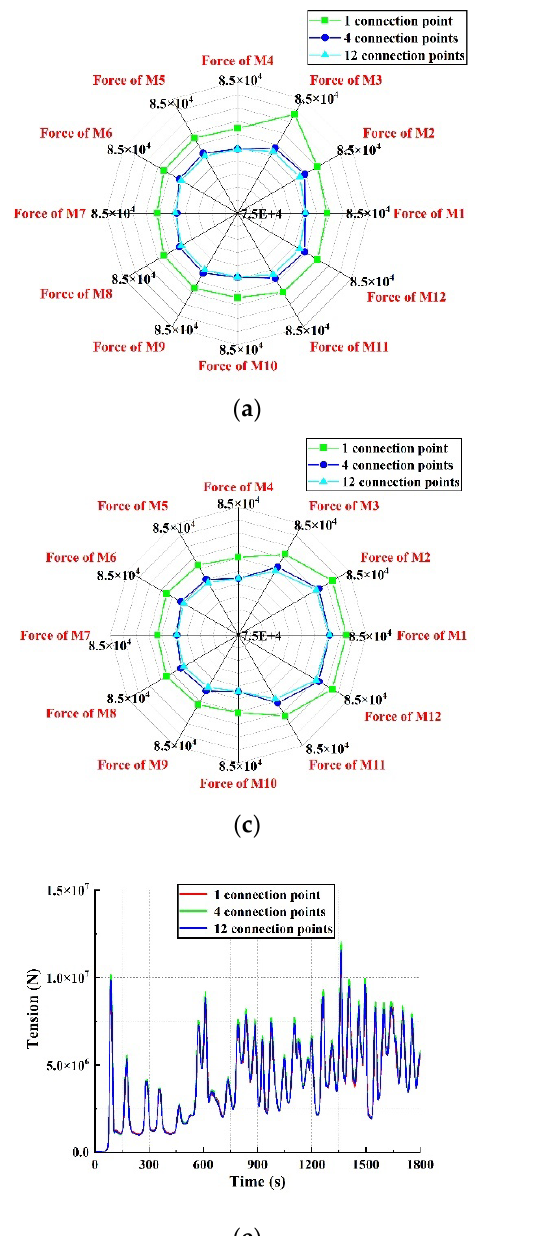
Figure 18. Influence of the number of connection points on the mooring system. ( a ) The coupled system for analysis with one connection point; ( b ) schematic diagram of the design of one connec- tion point; ( c ) the coupled system for analysis with four connection points; ( d ) schematic diagram of the design of four connection points; ( e ) the coupled system for analysis with twelve connection points; ( f ) schematic diagram of the design of twelve connection points.